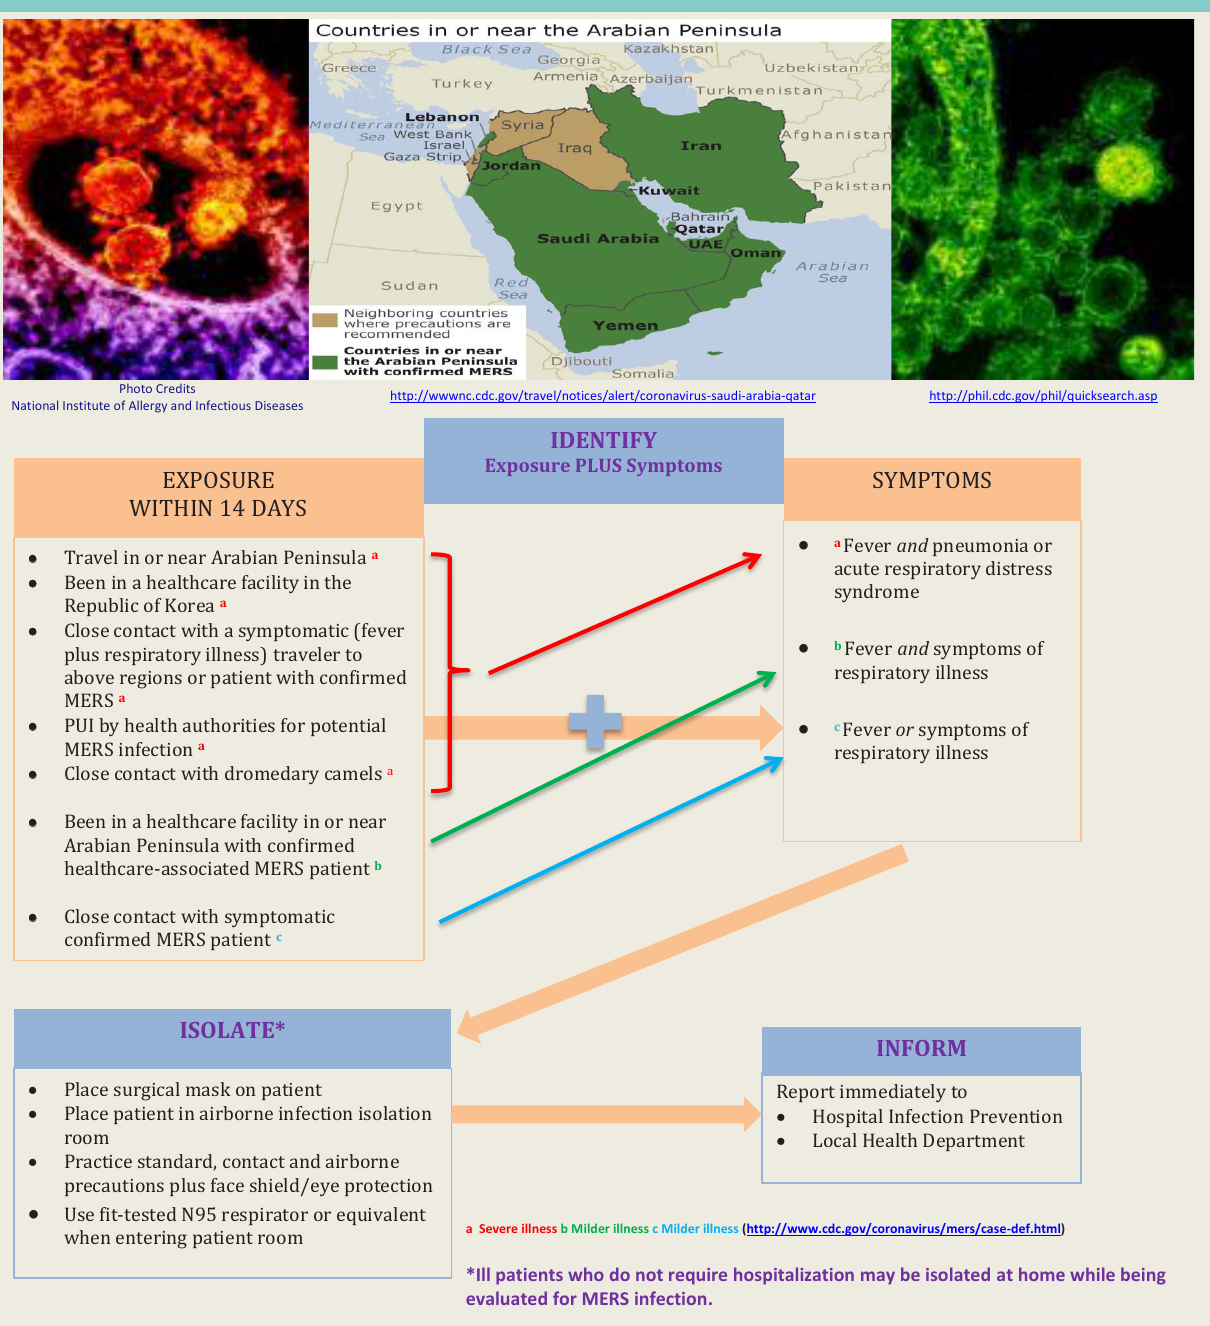
Figure 3. Koenig’s Identify-Isolate-Inform tool adapted for Middle East respiratory